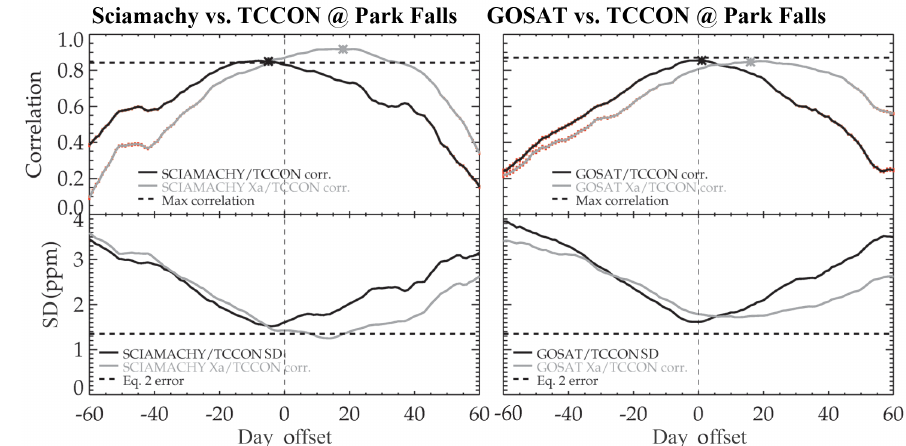
Figure 10. Top: cross correlation between TCCON and SCIAMACHY (top left) and GOSAT (top right) with matches using dynamic criteria at Park Falls. The x axis shows results when satellite data are offset in days vs. TCCON. The dashed line shows the expected maximum correlation based on the error (see Eqs. 2 and 3). The gray line is the correlation for the satellite priors, which are each out of phase by at least 10 + days. The * is the peak of a polynomial fit of the correlation between − 25 and + 25 days. Bottom: standard deviation between TCCON and SCIAMACHY (bottom left) and GOSAT (bottom right). The dashed line shows the Eq. (2) predicted error. Table 5. The left two numerical columns show standard deviation drop within ± 2 days of zero offset. Higher values with either model indicate sites where temporal co-location is more important. The next two numerical columns show calculated phase difference between CT2013b, MACC, and TCCON in days, with entries larger than 10 in bold. A phase difference of − 10 days means that the model seasonal cycle is 10 days behind TCCON. The next four columns show the same calculations for SCIAMACHY and GOSAT prior and retrieved values, with entries larger than 10 in bold. Blank values are those for which a good fit was not found.